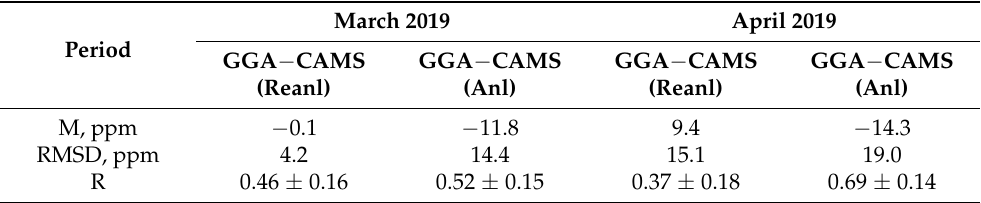
Table 5. Statistical characteristics of the difference between the CAMS and observation data for Peterhof in March and April 2019; Reanl: reanalysis; Anl: analysis.